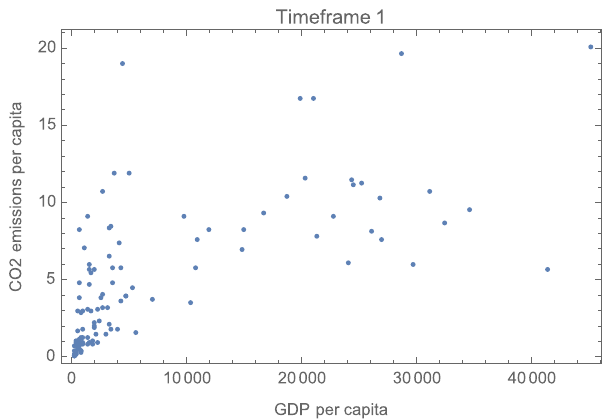
Fig. A.5. CO 2 as a function of GDP in time frame 1 for all countries.